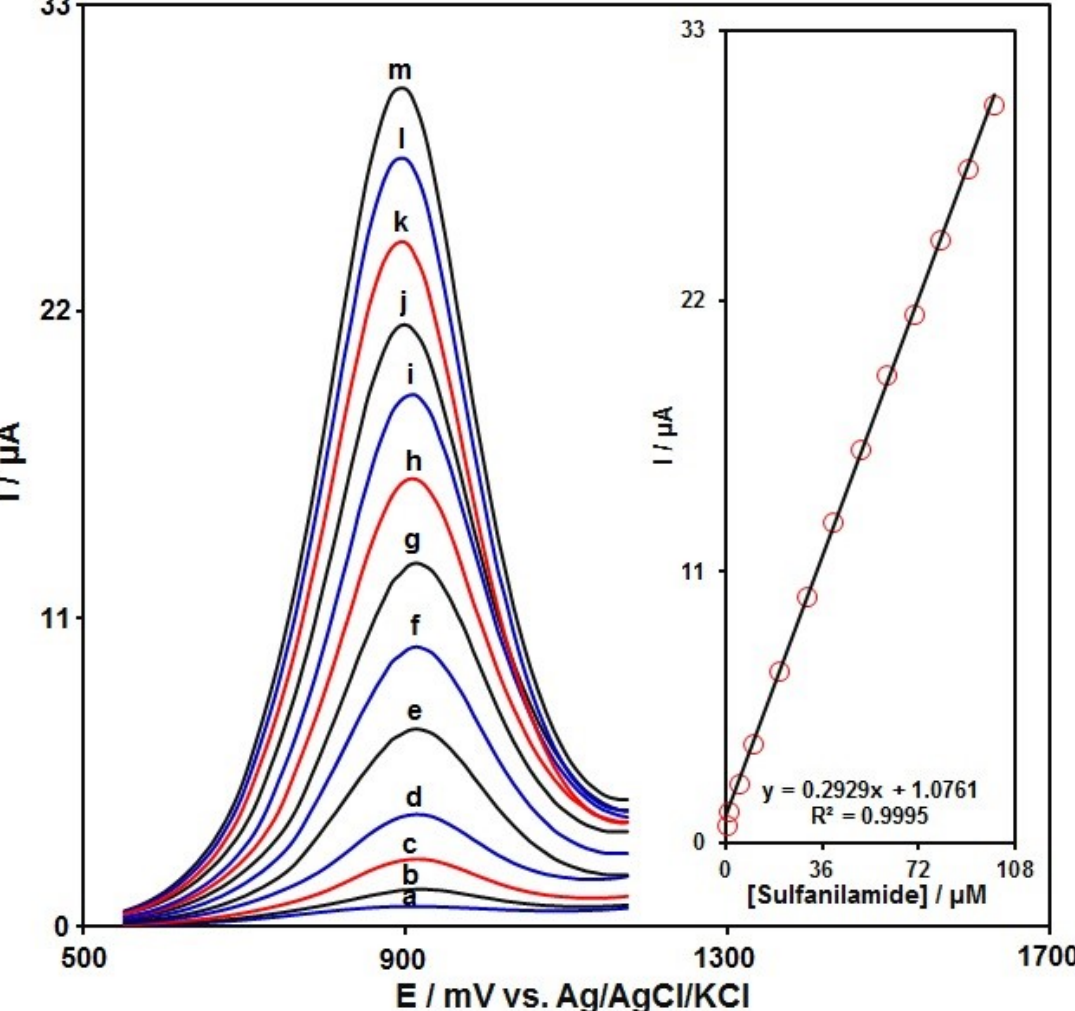
Figure 10. DPVs captured for MnO 2 NR-IL/CPE in PBS (0.1 M) at the optimized pH of 7.0 under exposure to various SAA contents; nos. a to m correspond to 0.07, 0.7, 5.0, 10.0, 20.0, 30.0, 40.0, 50.0, 60.0, 70.0, 80.0, 90.0 and 100.0 μ M of SAA; Inset: plot of peak current as a function of various SAA contents (0.07–100.0 μ M). Table 1. Comparison of the linear range and detection limit obtained for MnO 2 NR-IL/CPE with the determination of SAA with other sensors.